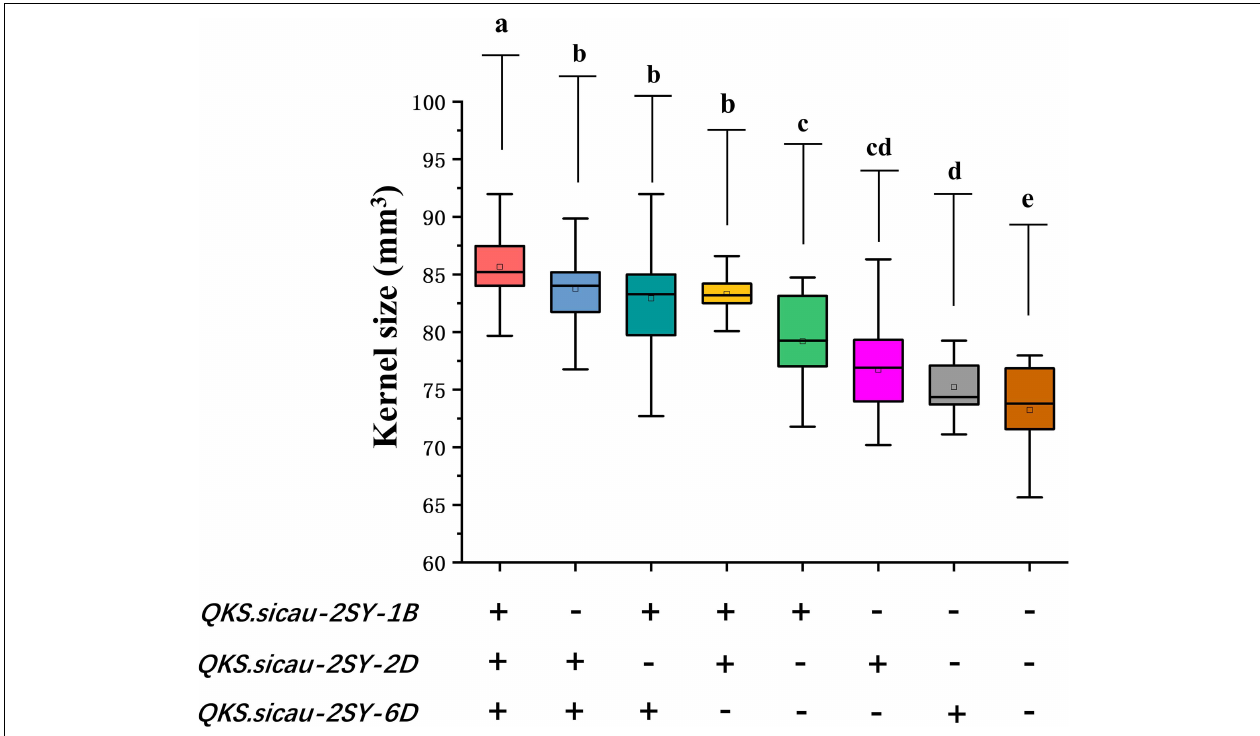
FIGURE 5 | Pyramiding analysis of QKS.sicau-2SY-1B , QKS.sicau-2SY-2D , and QKS.sicau-2SY-6D for KS; “+” and “-” represent lines with and without the positive alleles of the target quantitative trait loci (QTLs) based on the flanking markers of the corresponding QTL, respectively. Letters a, b, c, d, and e represent significant